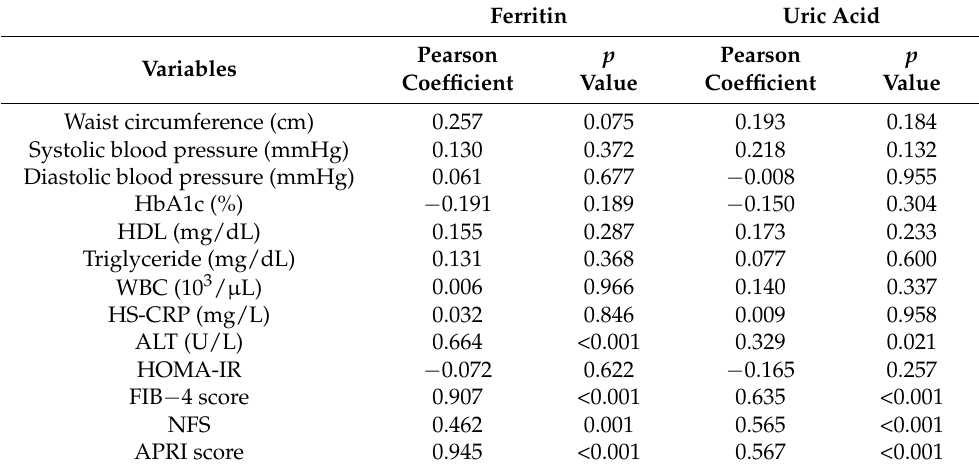
Table 2. Correlation between serum ferritin, uric acid concentration, and lean MAFLD metabolic risk.